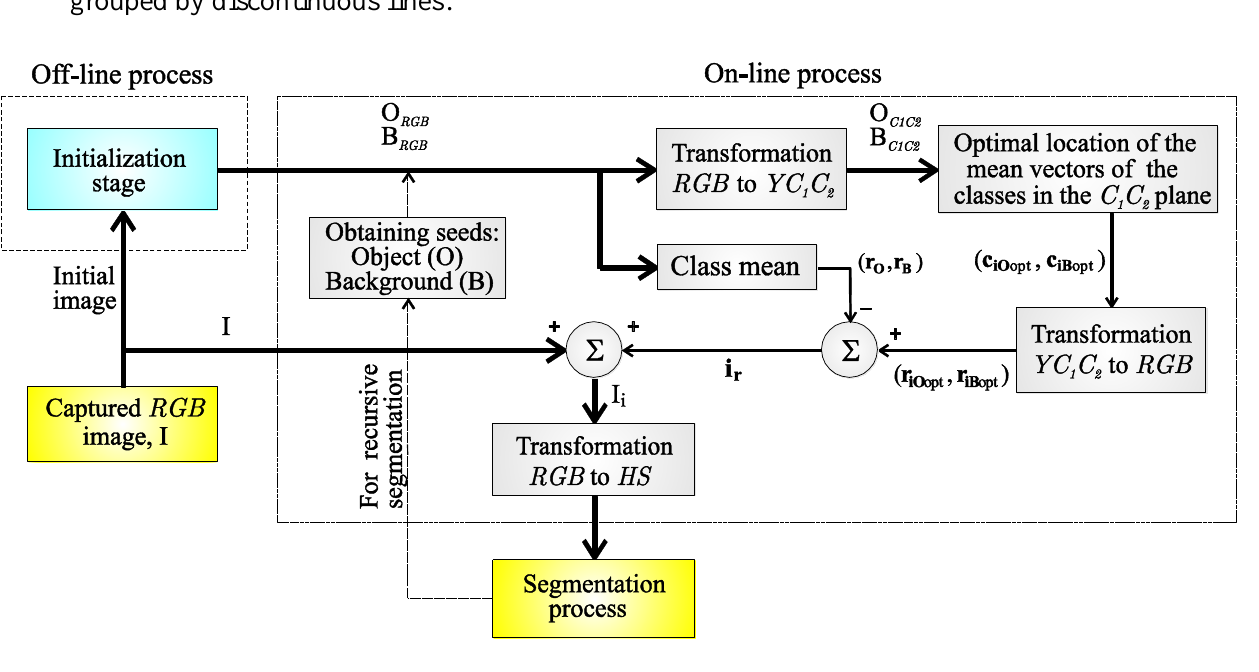
Figure 1. General block-diagram of the proposed algorithm to obtain the optimal colour vector ( i ) to be injected to the captured image I. The off-line and on-line processes are r grouped by discontinuous